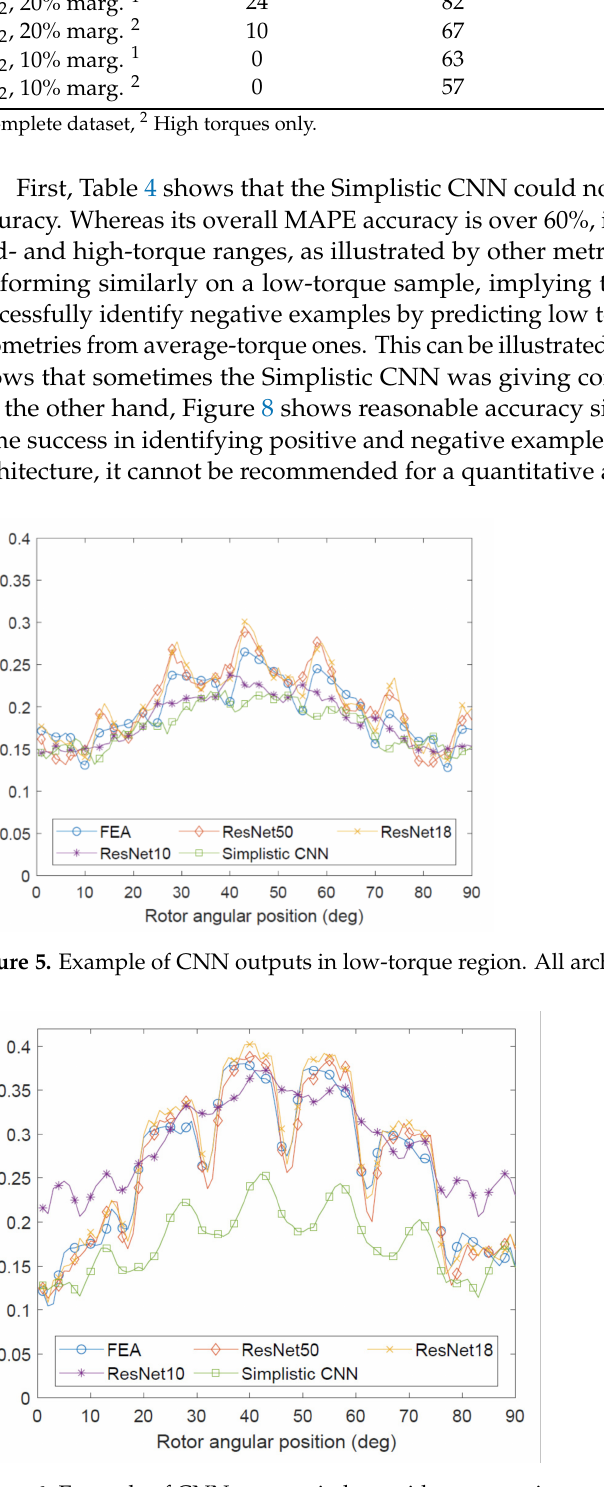
Figure 6. Example of CNN outputs in low-mid torque